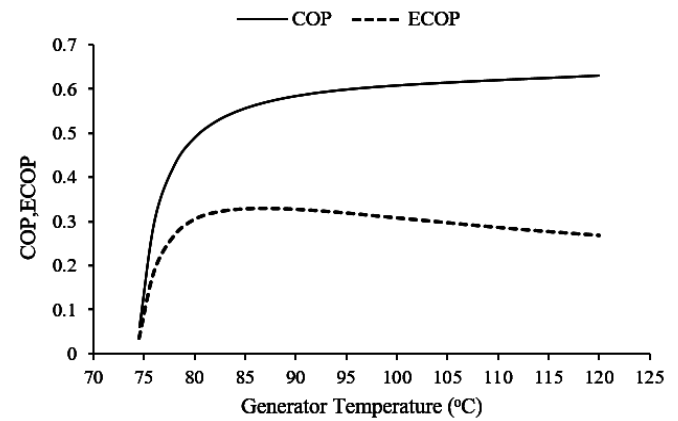
Figure 7. Effect of T gen on COP and ECOP.